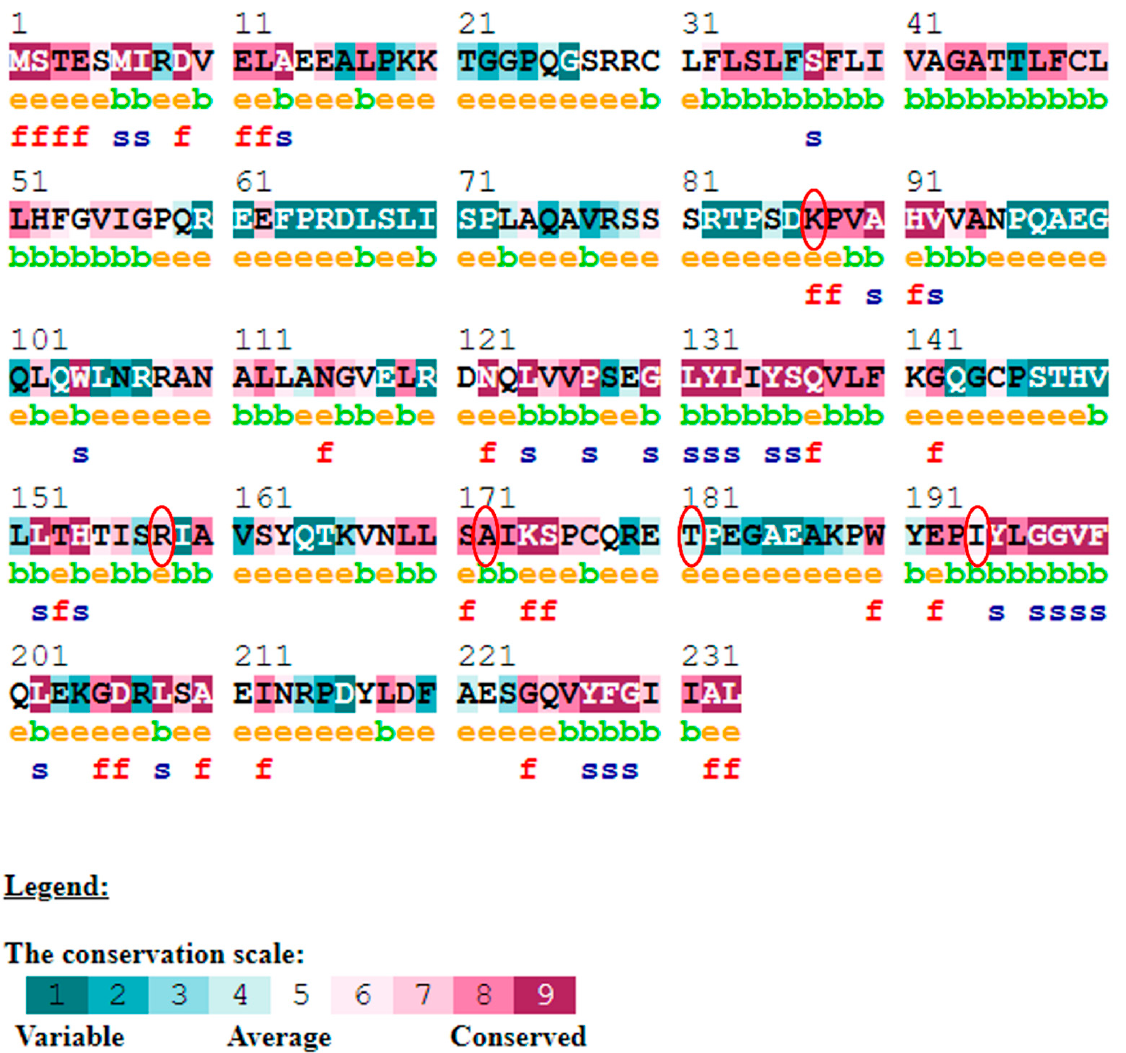
Figure 7. ConSurf server predicted conserved amino acids in TNF-protein. Based on the conservation scale, the amnio acids are ranked as variable, average, and conserved.